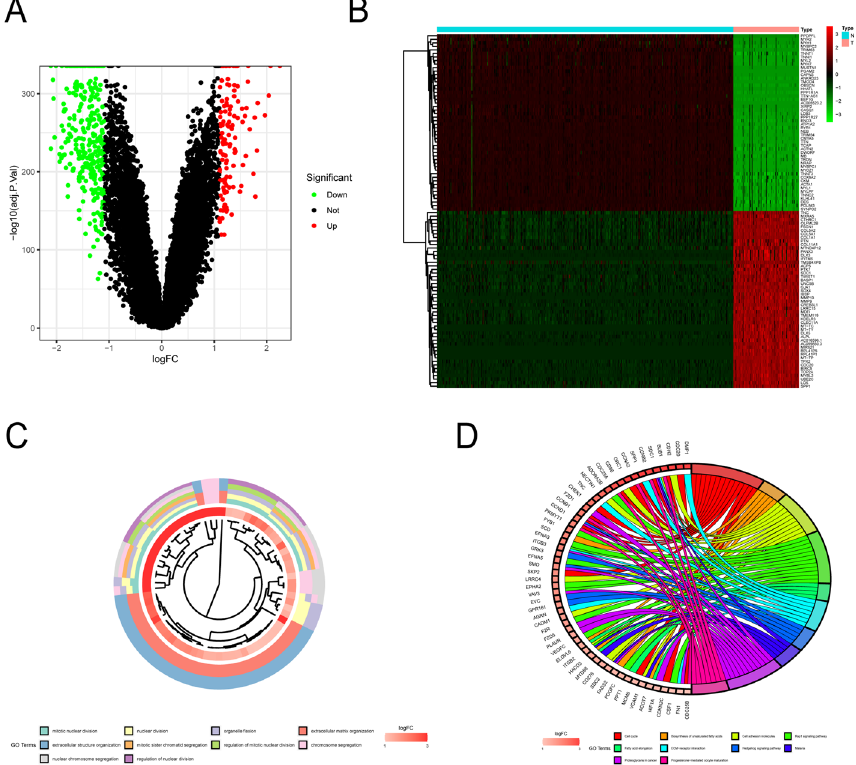
Figure 1. Analysis of differentially expressed genes related to osteosarcoma and enrichment analysis of differentially expressed genes related to hypoxia. ( A ) The volcano plot of DEGs. The red dots indicate genes that have a high expression level, the green dots indicate genes that have a low expression level, and the black dots indicate genes that do not meet our requirements. ( B ) The heat map of DEGs. In the Type column, blue represents normal samples, and red represents tumor samples; red in the graph indicates genes with high levels of expression, while green indicates genes with low levels of expression. ( C ) The Gene Ontology (GO) enrichment analysis of hypoxia-related genes. Different color modules represent different GO terms. The color in the innermost circle represents the logFC value of the gene. ( D ) The top 10 Kyoto Encyclopedia of Genes and Genomes (KEGG) pathways related to hypoxia. The different color modules on the right side of the graph represent different KEGG pathways; the left side represents genes, and the intensity of red indicates the logFC